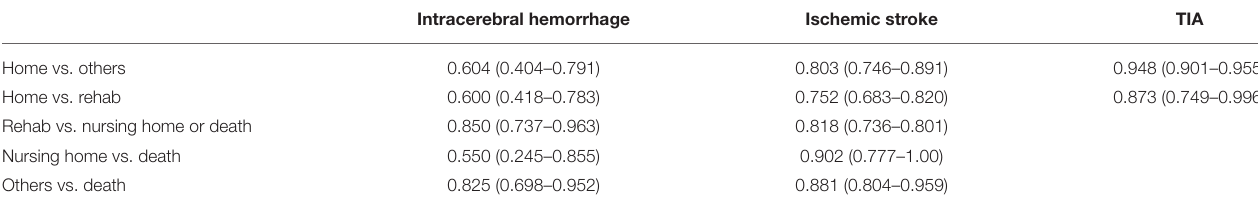
TABLE 4 | AUC of prediction for three different sub-cohorts of stroke at five different settings. Intracerebral hemorrhage Ischemic stroke TIA Home vs. others